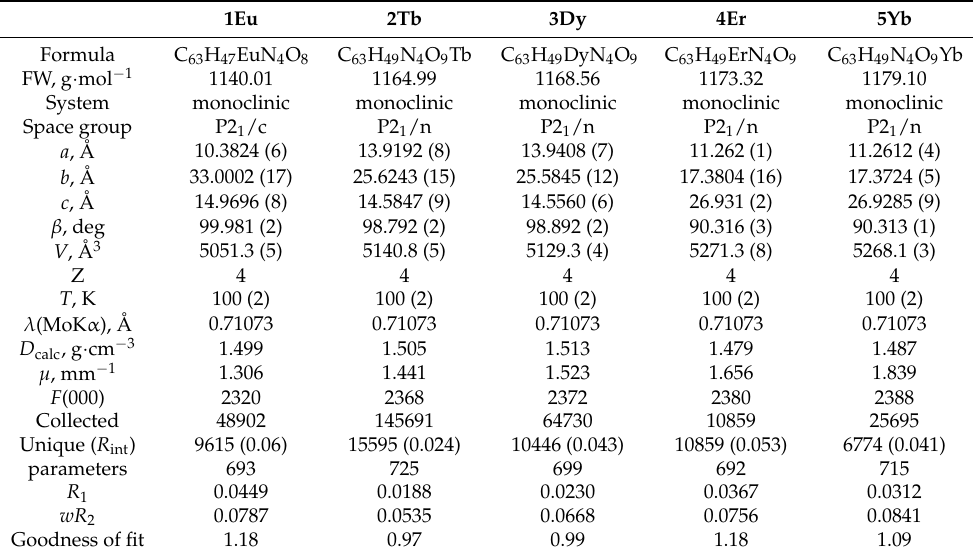
Figure 1. ( a ) Structure of 1Eu partially labeled. Hydrogen atoms are omitted for clarity. Color code: gray = C, blue = N, red = O and pink = Eu. ( b ) Coordination polyhedron of the Eu(III) ion in 1Eu . Table 1. Crystallographic data and data collection details for the X-ray structures of 1Eu – 5Yb .